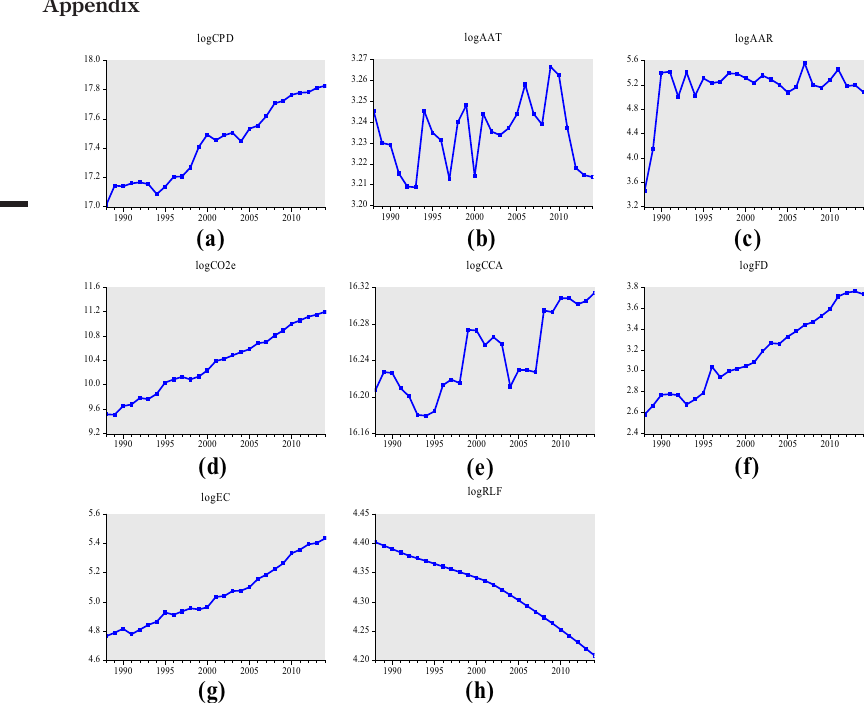
Figure A1. Visual plot of study variables